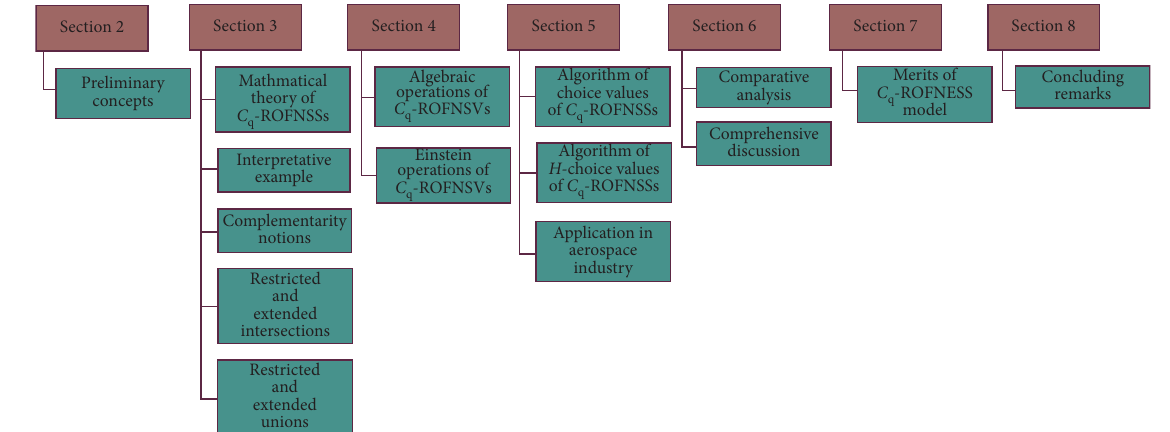
Figure 1: Graphical demonstration of proposed